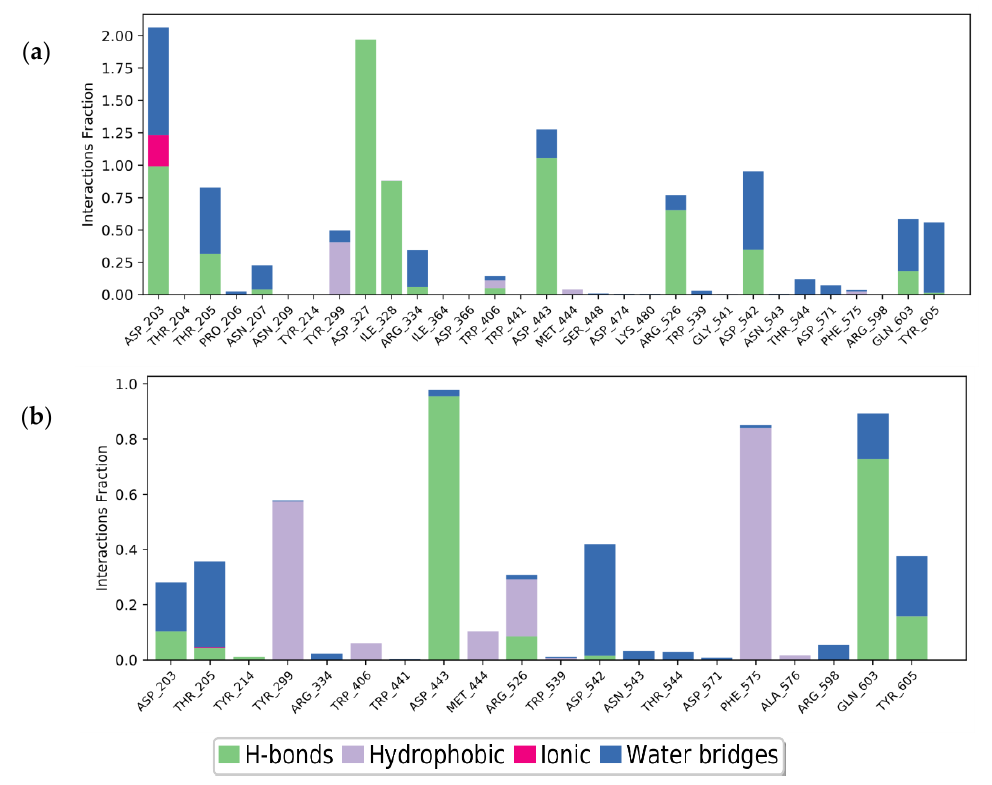
Figure 5. Protein-ligand interaction of: ( a ) acarbose and ( b ) naringenin, after 20 ns MD simulation time.